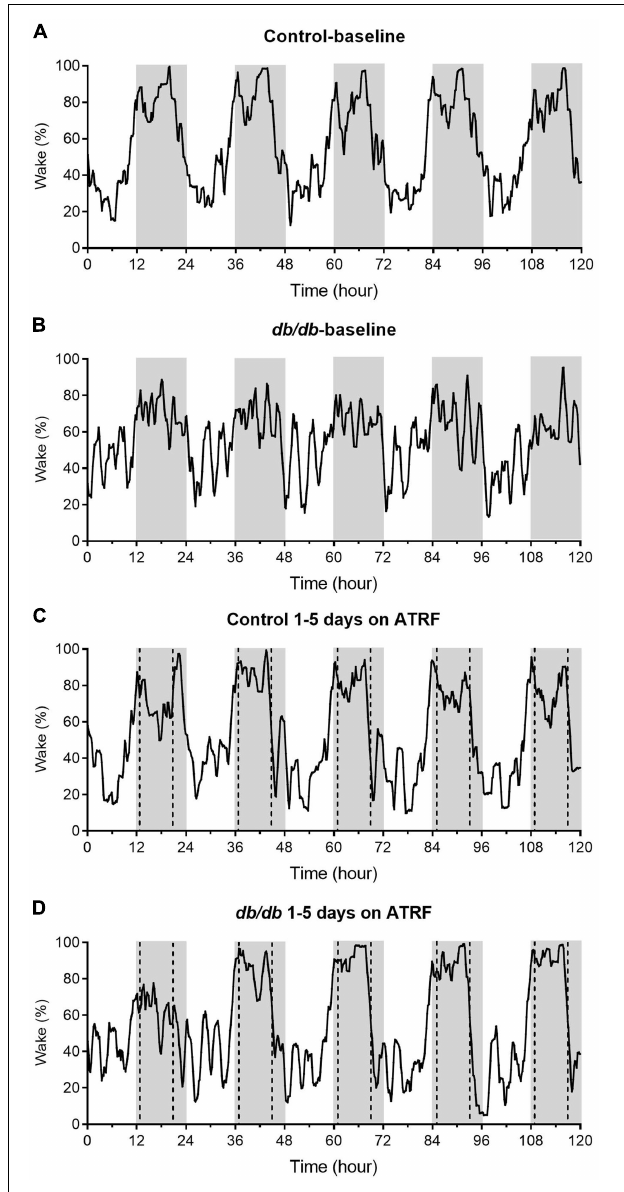
FIGURE 1 | Representative sleep-wake profiles of the control and db/db mice with ALF and the 1–5 days of ATRF. The sleep-wake profiles in the control mice with ALF (A) or ATRF (C) and in the db/db mice with ALF (B) or ATRF (D) . The gray box indicates the dark-phase. The dotted vertical line in C,D indicates the time when food was added or withdrawn during the ATRF feeding